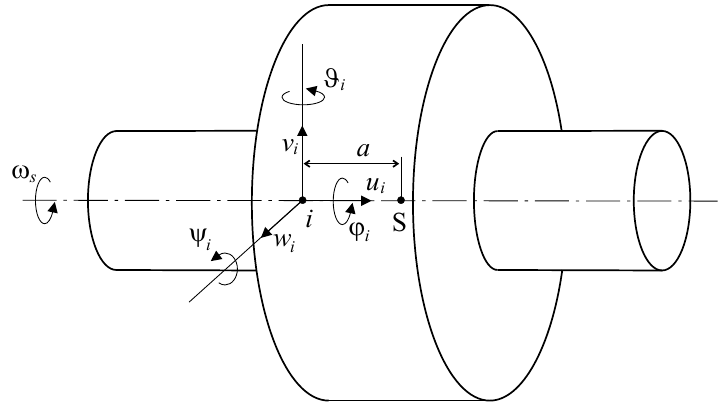
Figure 3. Schematic view of a rotating rigid body (disk) attached to a